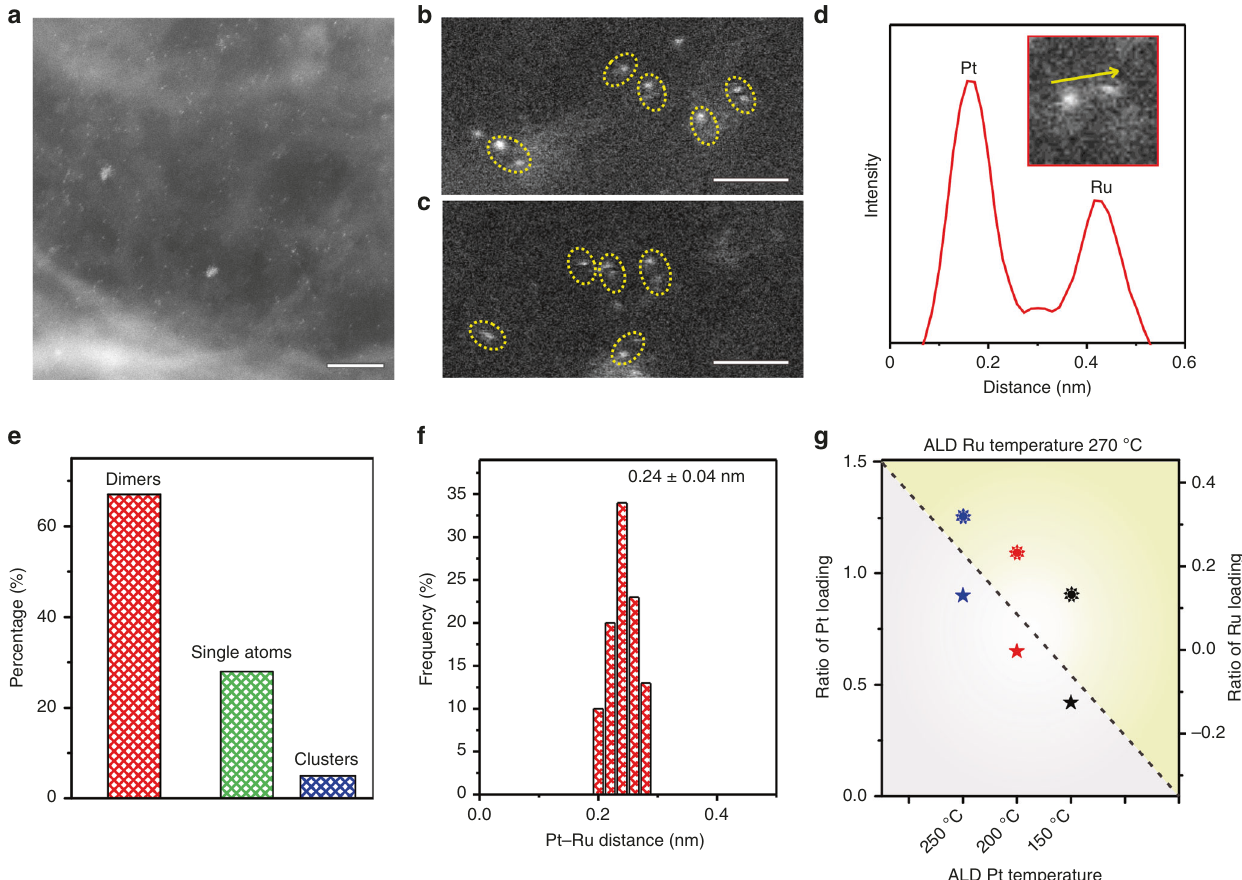
Fig. 2 Characterizations of Pt – Ru dimers. a – c Aberration-corrected HAADF-STEM images of Pt – Ru dimers/NCNTs. Scale bars, 5 nm ( a ); 1 nm ( b , c ). The slowly varying contrast is due to the changes in the thickness of the substrate. d The intensity pro fi le obtained on one individual Pt – Ru dimer. e Distribution histogram showing the ratio between dimers, single atoms and clusters. We determined the percentage of dimers by counting 200 clusters. f Pt – Ru distance in the observed Pt – Ru dimers. g The ratio of Pt and Ru loading in Pt – Ru dimers/NCNTs, which were obtained under different ALD